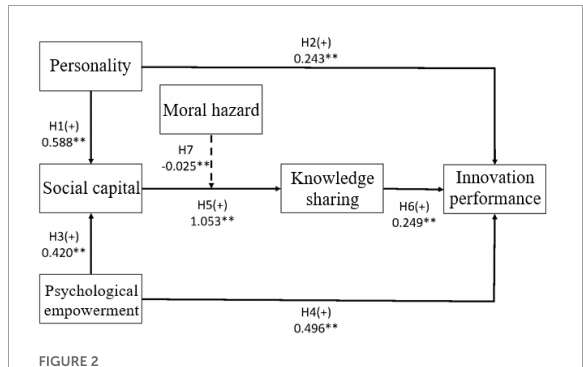
FIGURE2 Empirical results of the path analysis. **Denotes p <